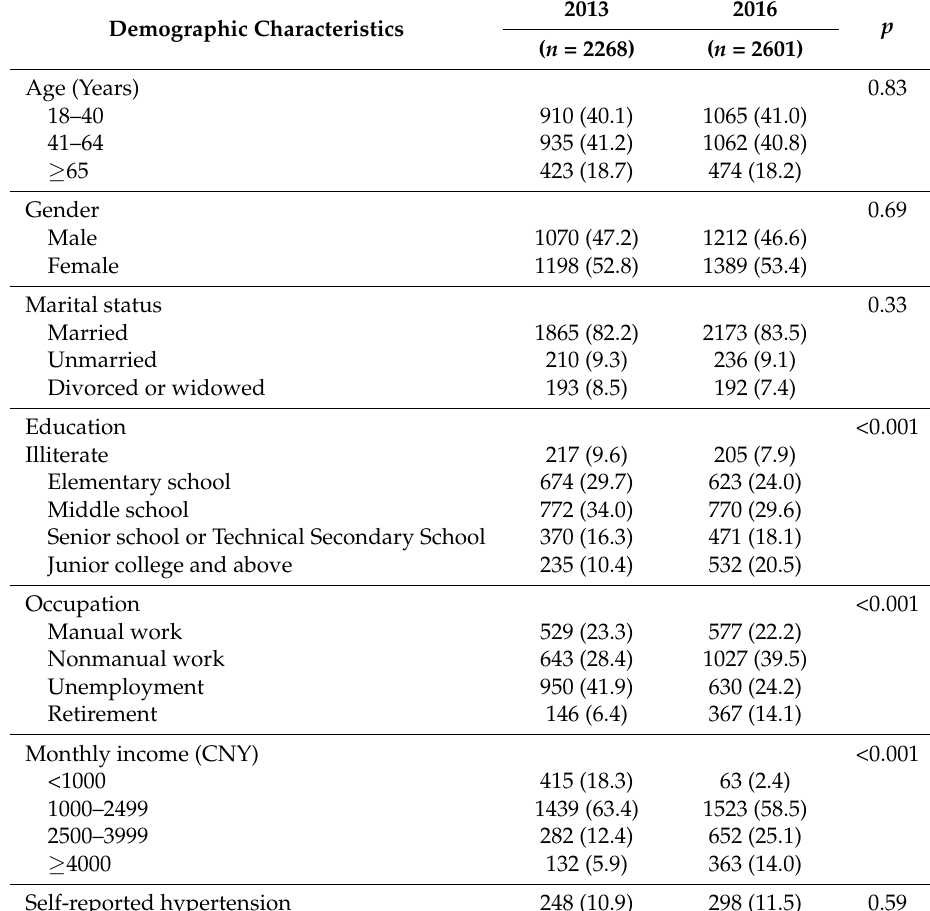
Table 1. Demographic characteristics of respondents.